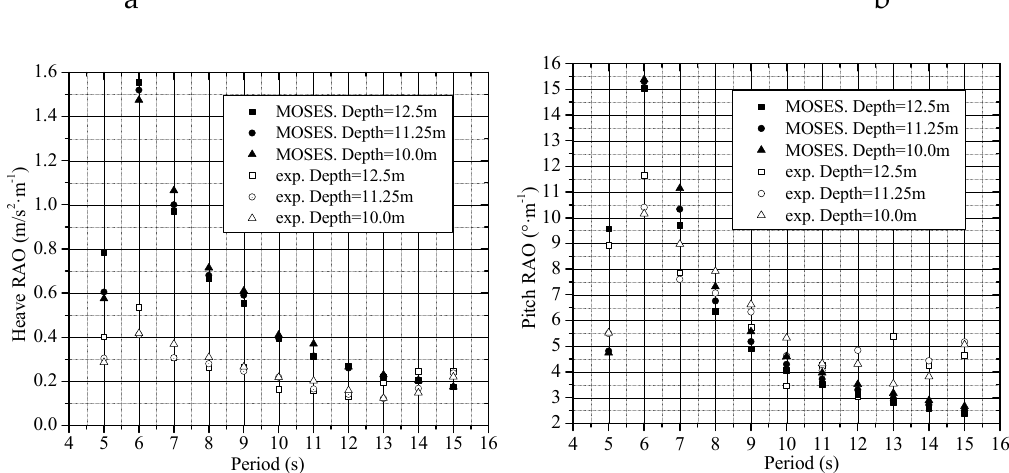
Figure 13. Experimental and simulated RAOs for three different water depths: ( a ) heave RAO and ( b ) pitch RAO.